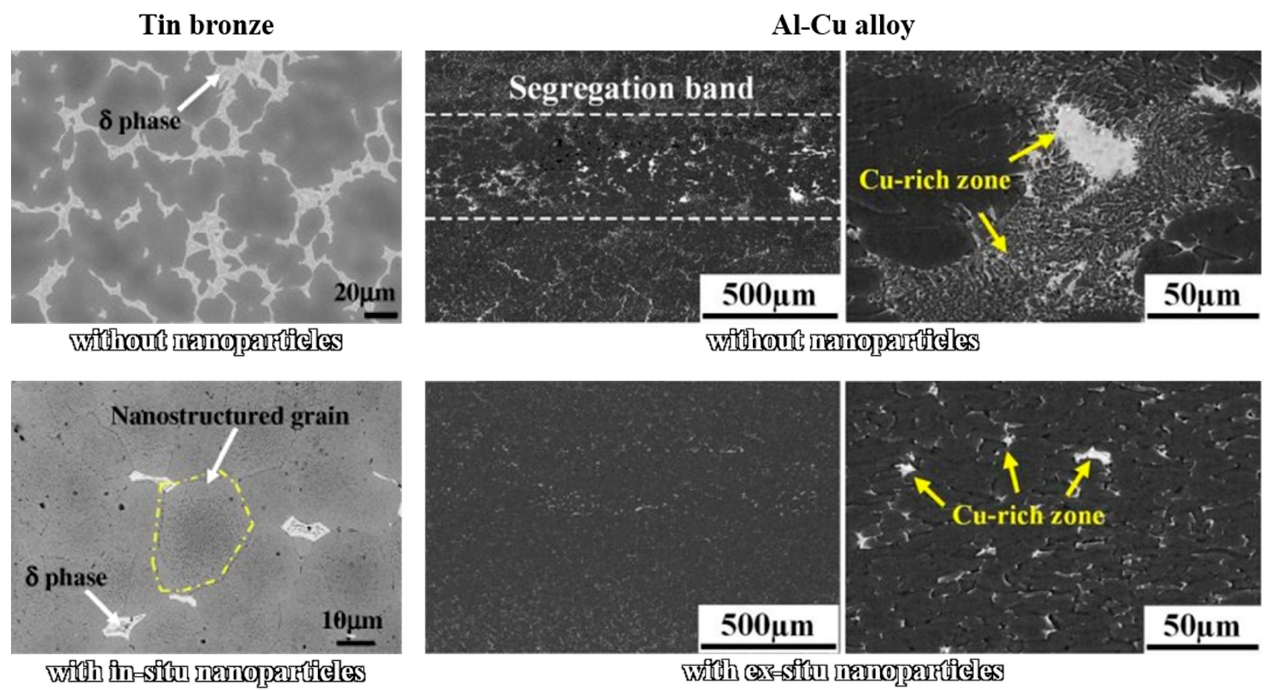
Figure 8. Inhibiting segregation caused by nanoparticles in tin bronze ( δ phase and nanostructured grain are marked by white arrows), reprinted with permission from ref. [73], 2022, Elsevier, Al-Cu alloy strip (Cu-rich zone are marked by yellow arrows), reprinted with permission from ref. [4], 2022, Elsevier.